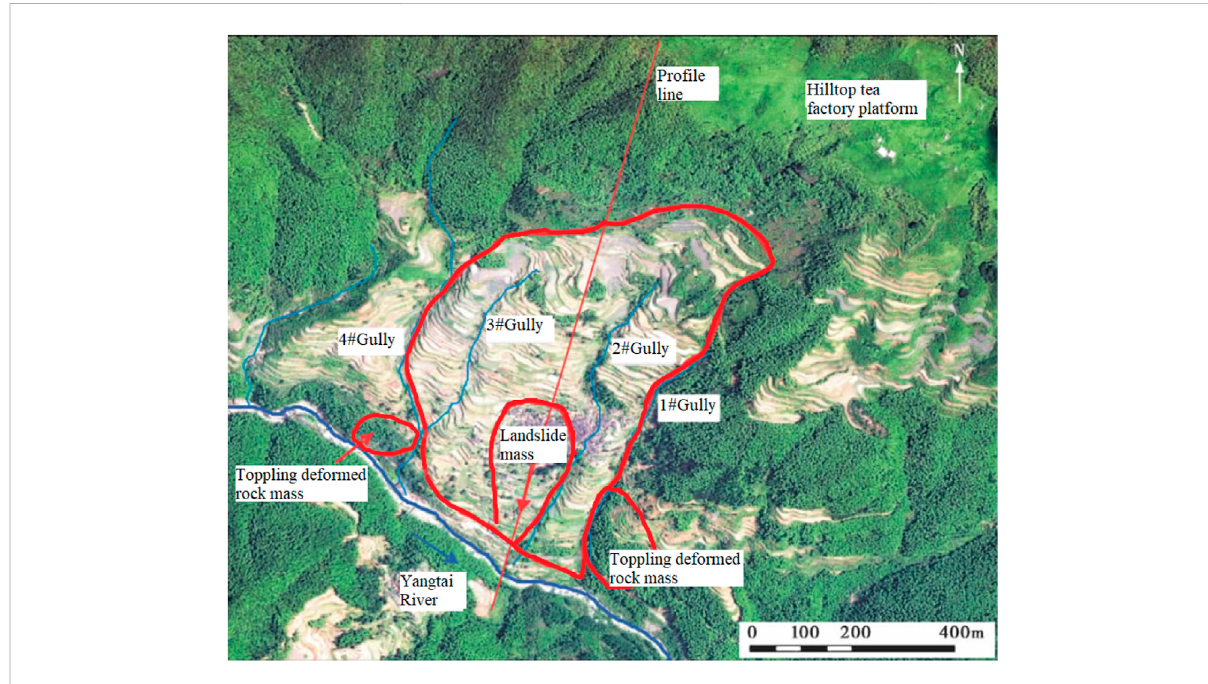
FIGURE 9 Remote sensing image of Yangtai slope.